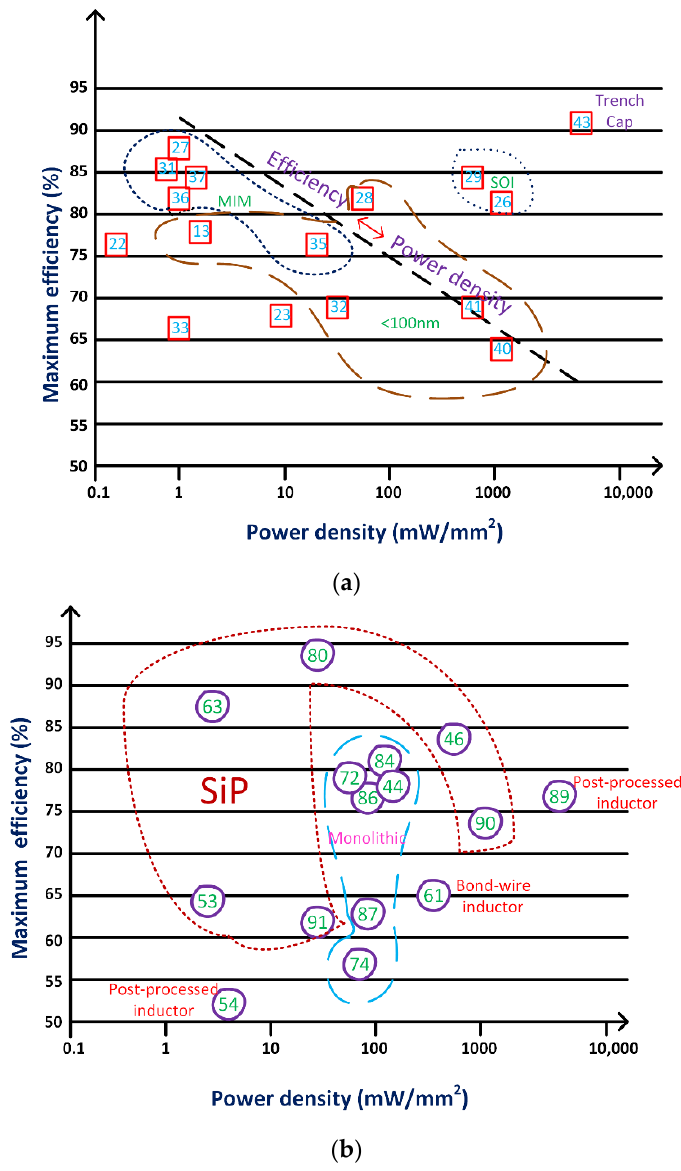
Figure 6. Comparison of maximum efficiency versus power density of various designs discussed in the literature for ( a ) switched-capacitor and ( b ) inductive converters [28]. Reproduced from [28] In Proceedings of the IEEE International Solid-State Circuit Conference: 2012.